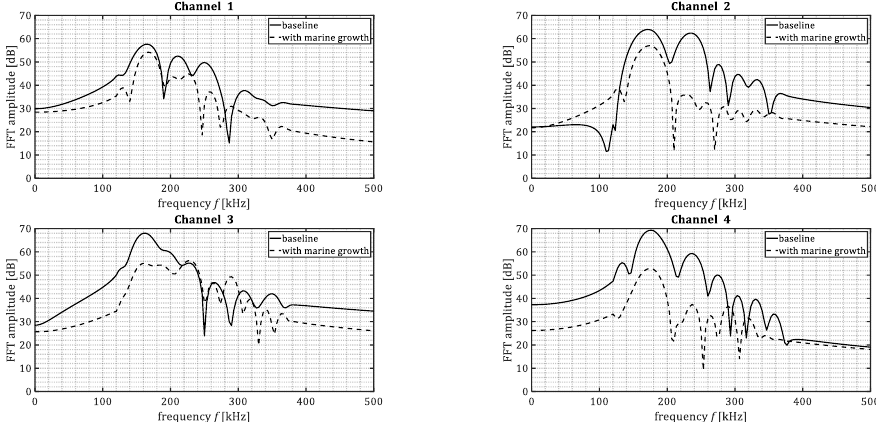
Figure 8. Samples of frequency spectrum of the processed pencil lead breaks signals for baseline plate and marine growth covered plate. plate and marine growth covered